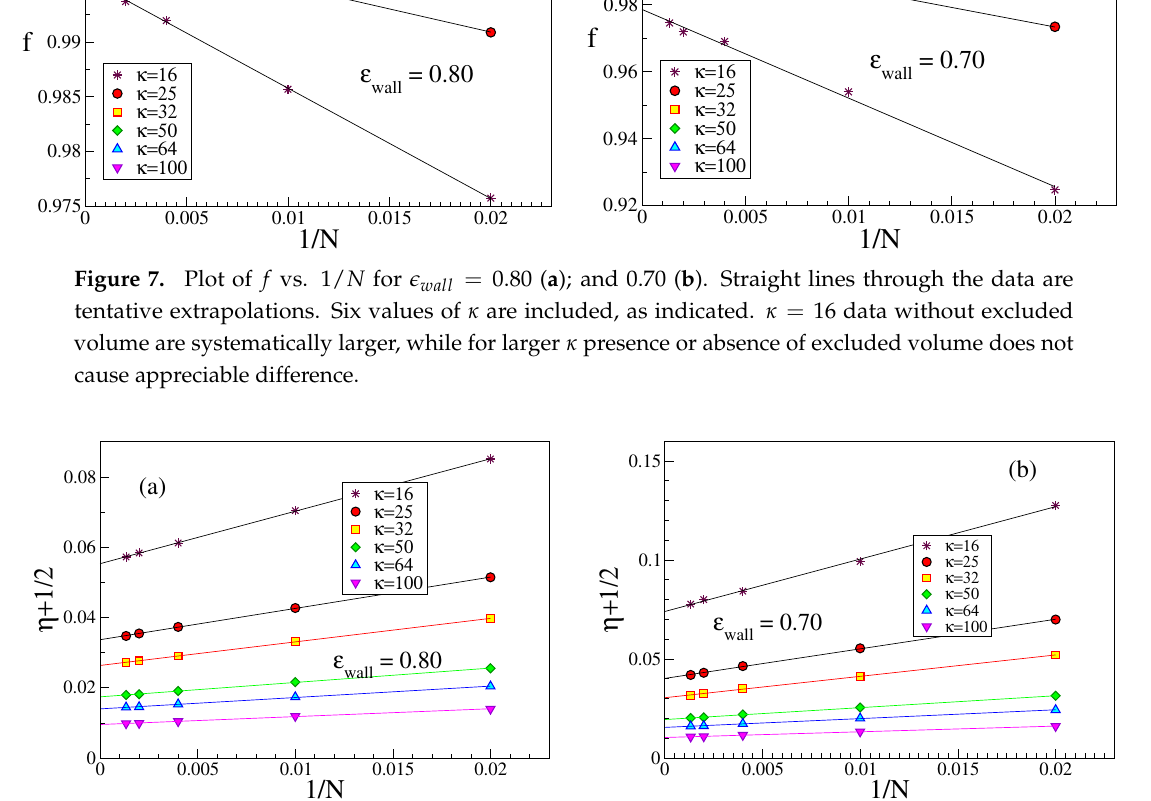
Figure 8. Deviation of the bond orientational order parameter η from value − 1/2, i.e., from perfectly parallel orientation, plotted vs. 1/ N for 6 stiffnesses κ , as indicated, for (cid:101) wall = 0.80 ( a ), and (cid:101) wall = 0.70 ( b ). Presence or absence of excluded volume interaction does not cause any difference on the data. Straight lines show tentative